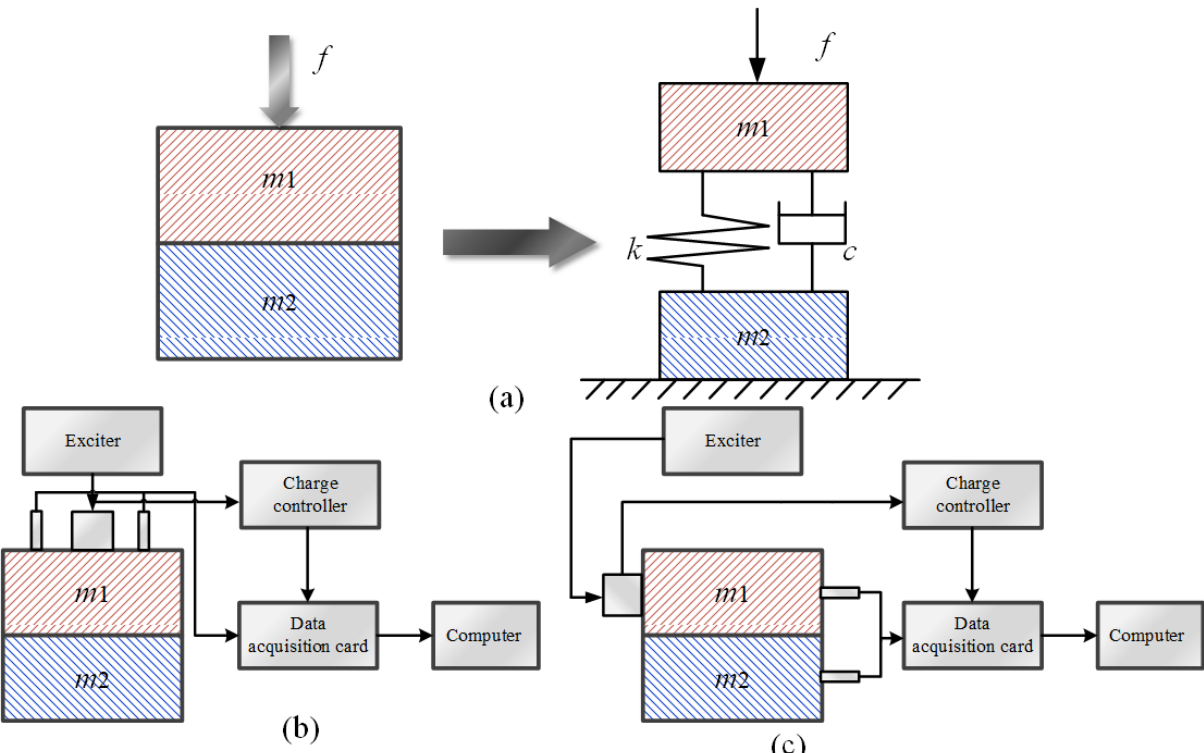
Figure 12. (a) Normal experimental study and dynamic model of normal experiment. (b) Normal parameter identification test system. (c) Cutting parameter identification experiment